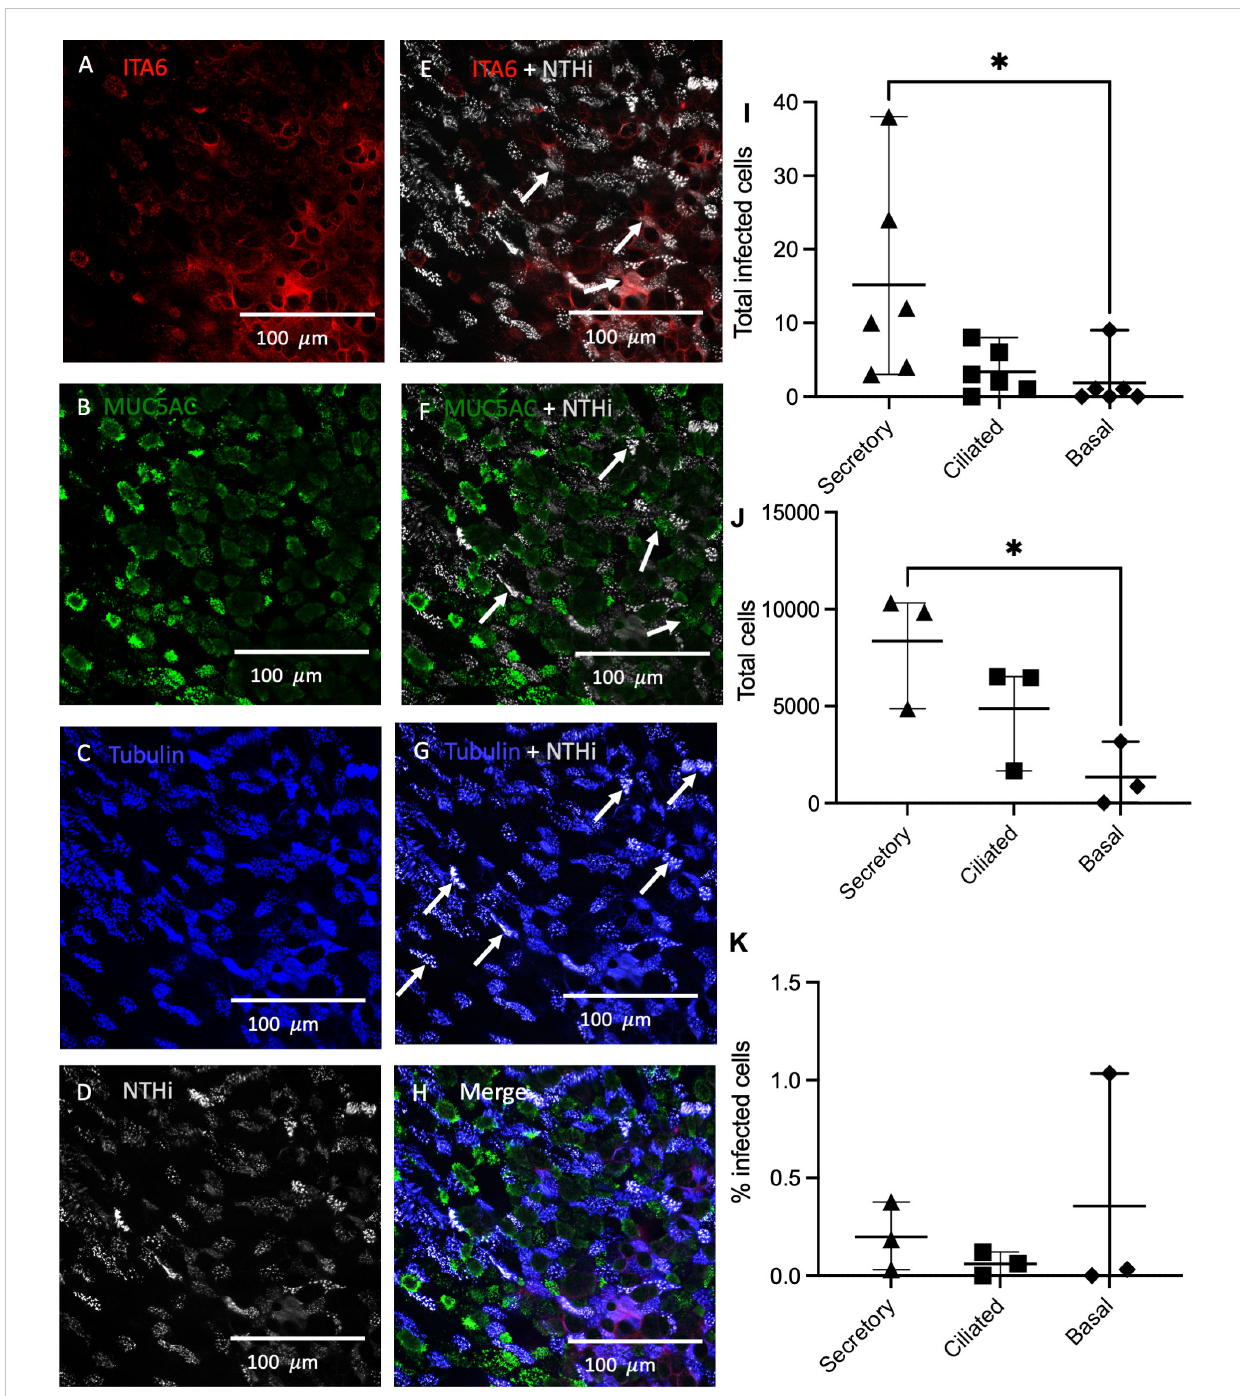
FIGURE 2 Rates of NTHi internalization in different epithelial cell types. PBECs cultured at ALI were infected with NTHi CFSE-stained strain 398 for 4 hours, fi xed in 4% PFA and then stained for ciliated, basal and goblet cell markers. (A) Basal cell marker Integrin subunit alpha-6 (ITA6). (B) MUC5AC marks secretory cells in green. (C) Acetylated alpha-tubulin indicates ciliated cells. (D) NTHi are labelled in grey to indicate CFSE-stained bacteria. (E) ITA6 and NTHi Merge. (F) MUC5AC and NTHi merge. (G) Acetylated alpha-tubulin and NTHi merge. (H) Merge of all staining. Arrows denote clusters of internalized NTHi. PBECs cultured at ALI and inoculated with NTHi were fl ow-sorted to determine proportion of each cell type infected by NTHi. (I) Internalization of NTHi expressed as total number of infected cells. (J) Relative composition of epithelial culture by cell type. (K) Percent of cells infected by cell type. n=3 biological replicates from healthy control donors, dots represent means of replicates. Differences compared by 2-way ANOVA with post hoc *, P<0.05 for Sidaks multiple comparisons